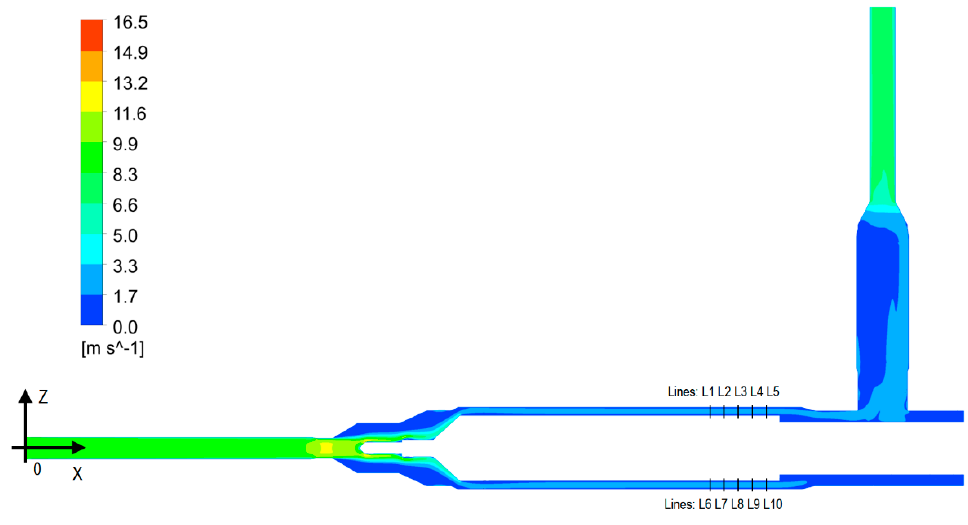
Figure 11. Velocity contour.